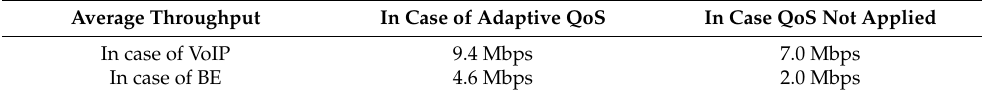
Table 14. Scenario 3 Performance